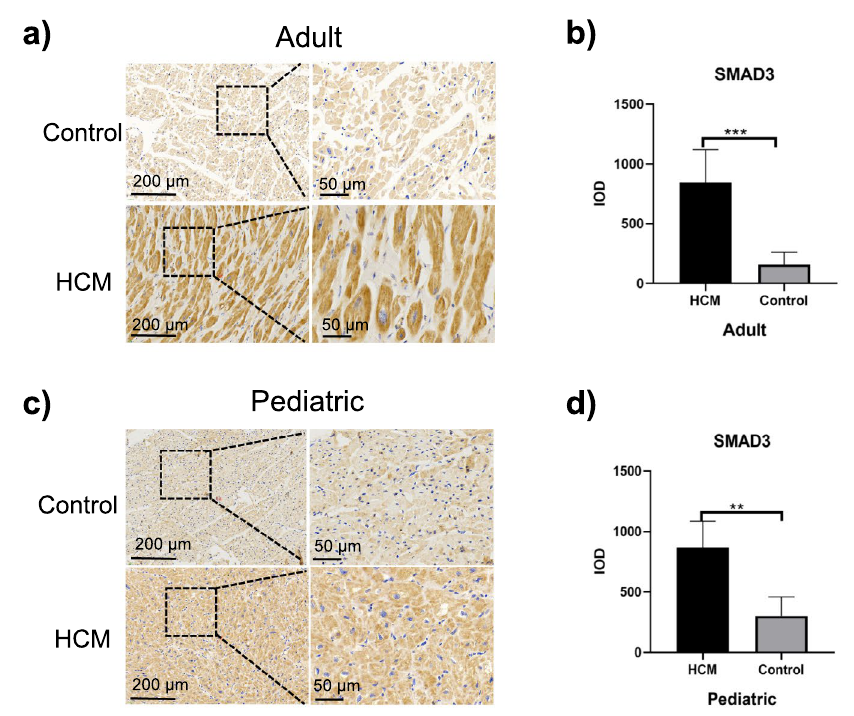
Figure 3. Immunohistochemical analysis of SMAD3 expression in ventricular septal myocardial tissue from patients with HOCM. ( a ) Representative images of immunohistochemical staining of SMAD3 in ventricular septal myocardial tissue from the control and adult HOCM patients. Scale bars, 200 μm and 50 μm (enlarged views of boxed areas). ( b ) Quantification of SMAD3 expression level in ventricular septal myocardial tissue from the control and adult HOCM patients. Data are mean ± SEM, *** p < 0.001. c. Representative images of immunohistochemical staining of SMAD3 in ventricular septal myocardial tissue from the control and pediatric HOCM patients. Scale bars, 200 μm and 50 μm (enlarged views of boxed areas). ( d ) Quantification of SMAD3 expression level in ventricular septal myocardial tissue from the control and pediatric HOCM patients. Data are mean ± SEM, ** p <